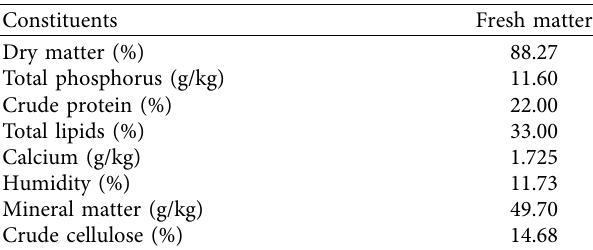
Table 1: Chemical composition of hemp seed ecotype Beldiya used in this